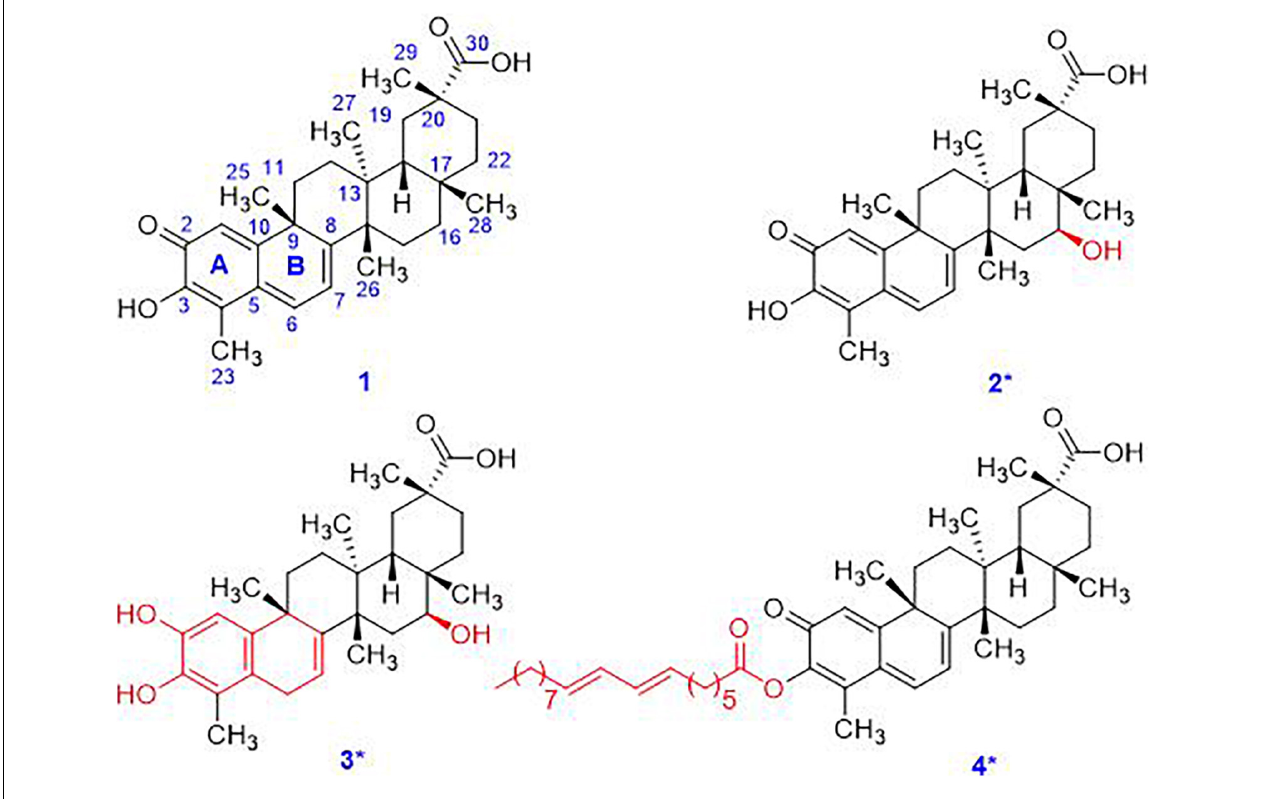
FIGURE 1 | The chemical structures of compounds 1 – 4 . Compounds 2 – 4 were new